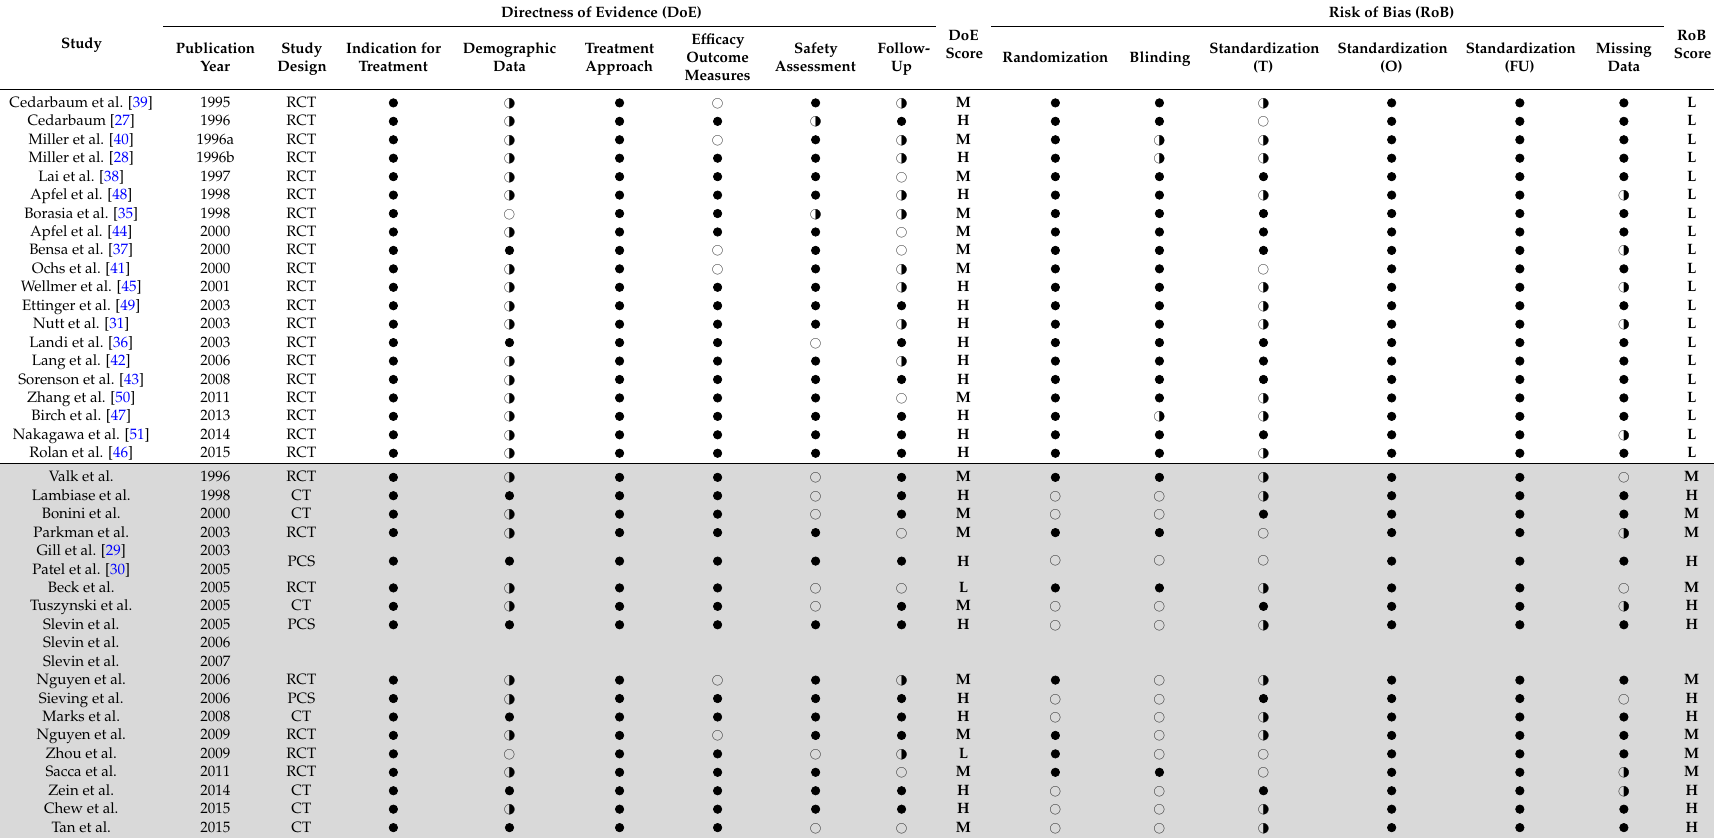
Table 1. Critical appraisal of selected studies reporting patients treated with neurotrophic